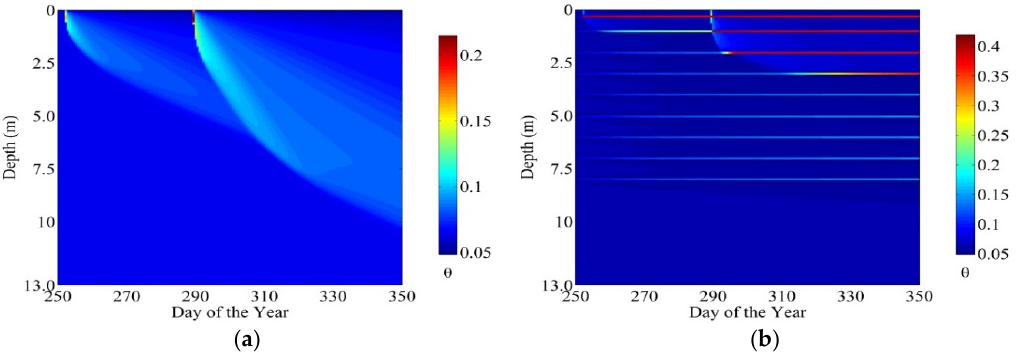
Figure 12. Simulated volumetric water content θ as a function of depth and time in days of the year, obtained for coarse texture sediments ( a ) and for nine think layers between coarse texture sediments ( b ).